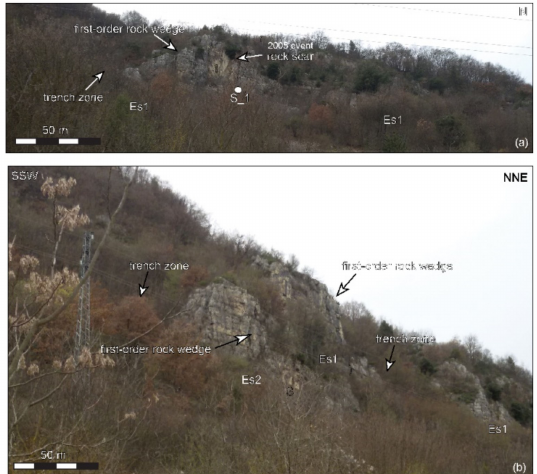
Figure 4. ( a , b ) Panoramic views of the tectonic-controlled escarpments Es1 and Es2 with evidence of main trench zones. The source area of the 2005 rockfall event and first-order rock wedges can be